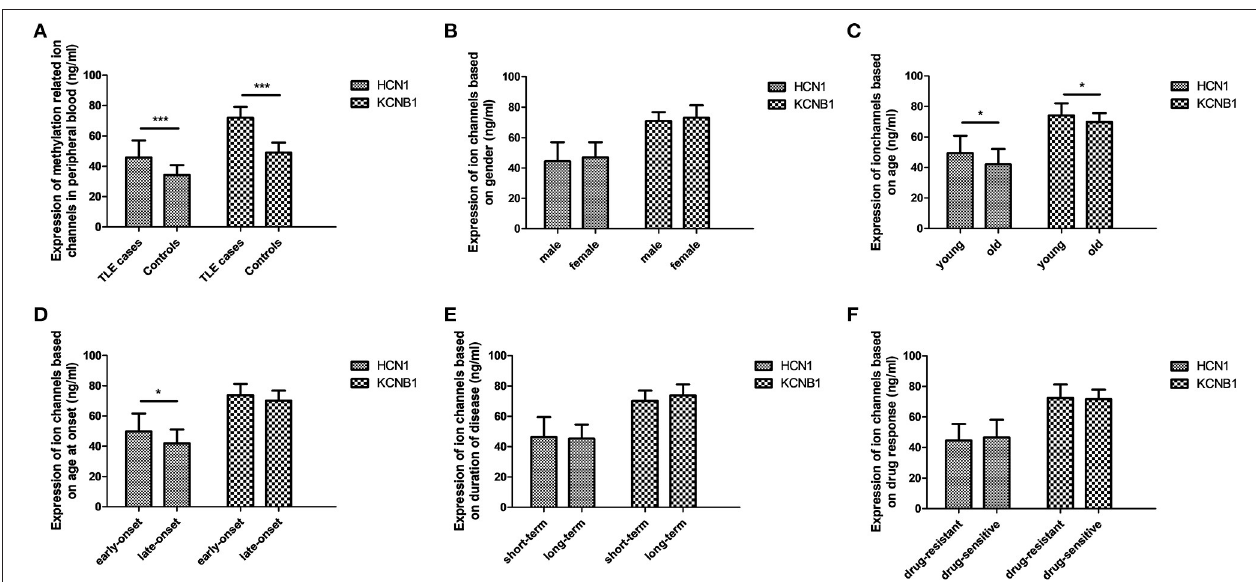
FIGURE 1 | Protein levels of selected ion channel genes in peripheral blood using ELISA. The protein levels of HCN1 and KCNA2 in the TLE group reached a significant level, with a 1.3-fold change and 1.5-fold change in comparison with the control group, respectively (A) . Within the TLE group, the levels of HCN1 protein were significantly increased in the young patients and in the early-onset patients (C,D) ; expression of KCNA2 was also significantly upregulated in young patients compared with old patients (D) , but no differences in HCN1 and KCNA2 were observed in accordance with stratified analysis of sex (B) , disease duration (E) , or drug response (F) . * p < 0.05; *** p <